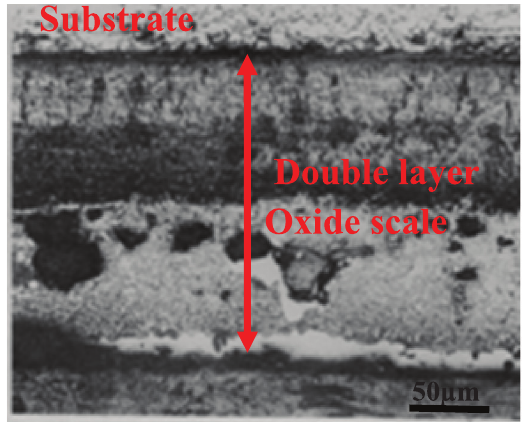
Fig. 4: Oxide scale at the inner surface of the